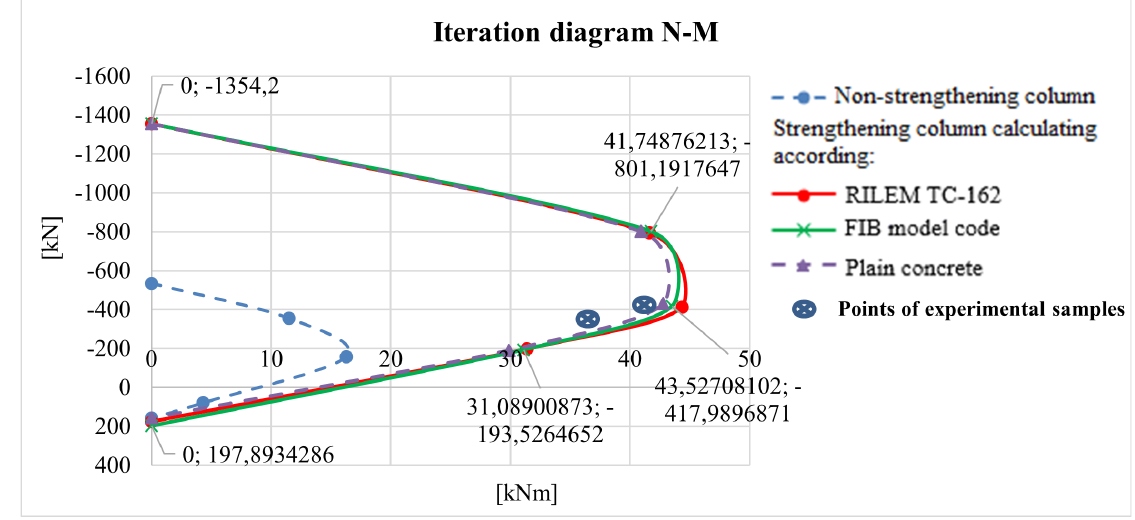
Figure 6. Iteration diagrams for individual methods of calculation - comparison.